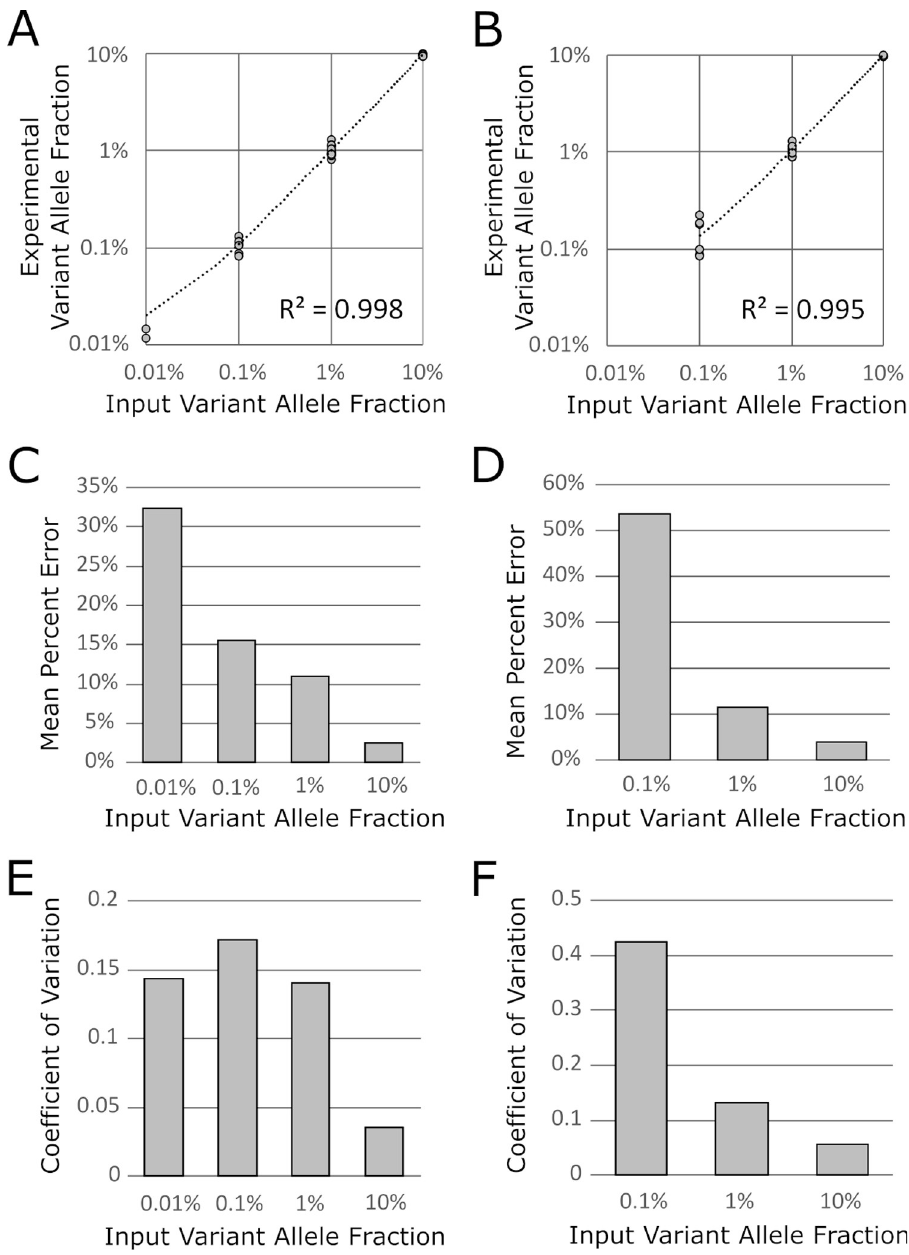
Fig 5. Experimental versus input variant allele fraction for specimens above limit of detection for EGFR L858R (A) and EGFR exon 19 deletion (B). Mean percent error decreases with increasing variant allele fraction for EGFR L858R (C) and EGFR exon 19 deletion (D). Coefficient of variation with respect to variant allele fraction for EGFR L858R (E) and EGFR exon 19 deletion